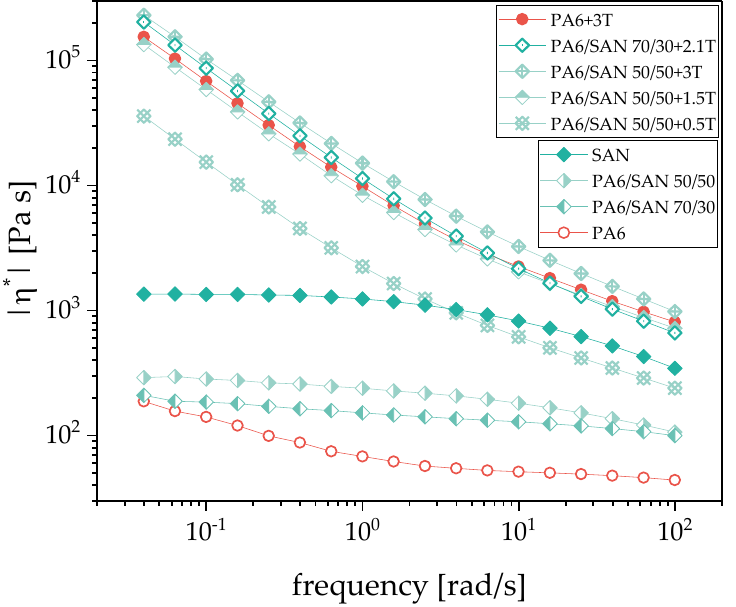
Figure 3. Complex melt viscosity | η *| of PA6, SAN, and PA6/SAN blends without and with different amounts of SWCNT filler Tuball (T).